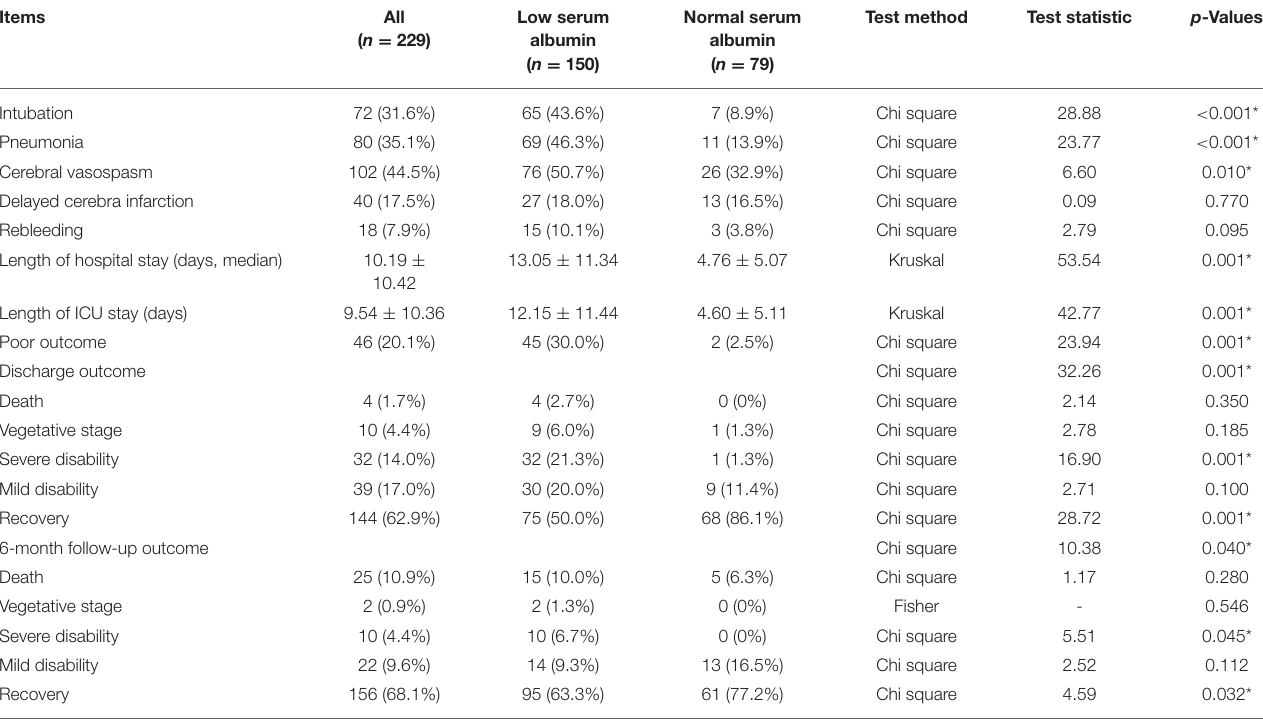
TABLE 2 | Correlation of serum albumin levels in patients with spontaneous subarachnoid hemorrhage. Items